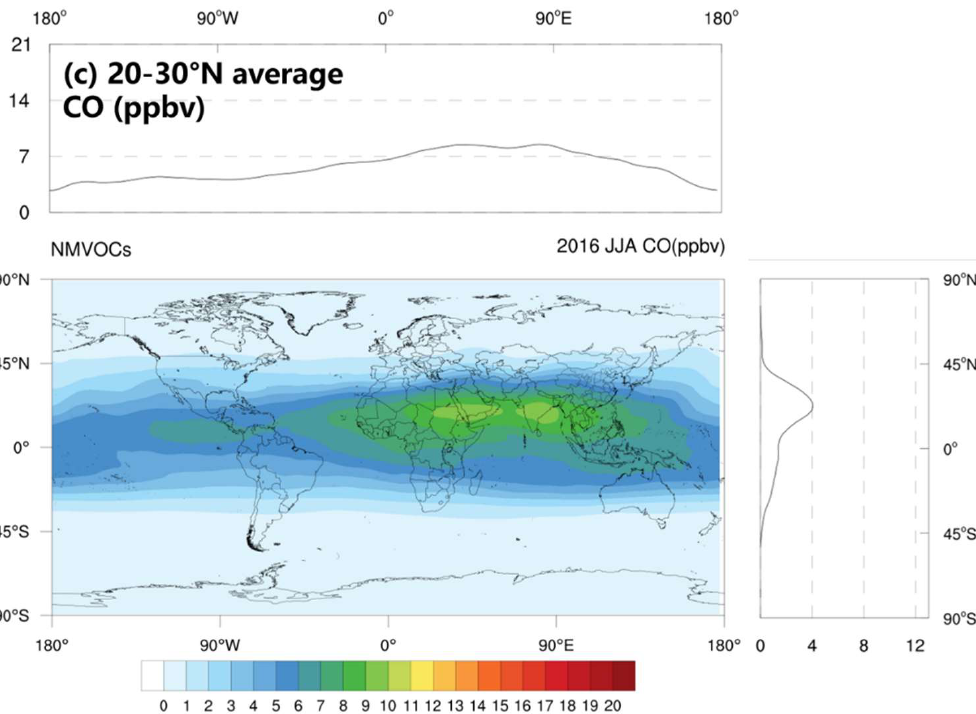
Figure 5. Effects of CO emissions ( a ) CH 4 ( b ) and NMVOCs ( c ) on CO concentration in the UTLS.